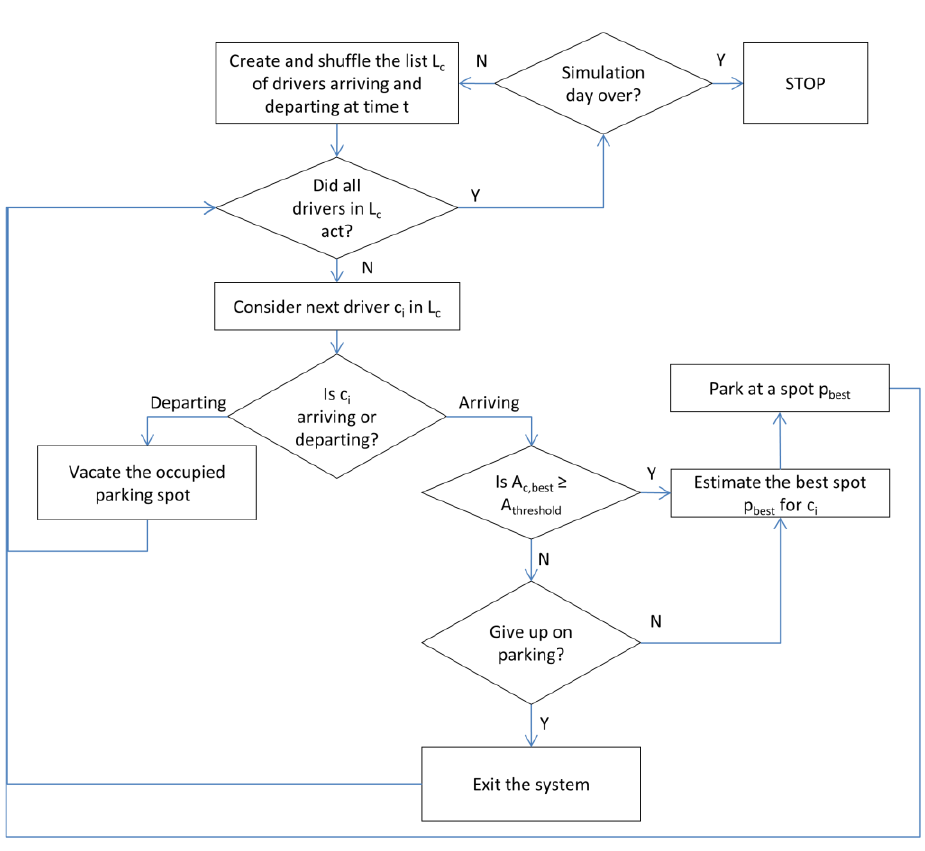
Figure 1. Flow chart of the Maximally Dense Parking Pattern (MDPP)